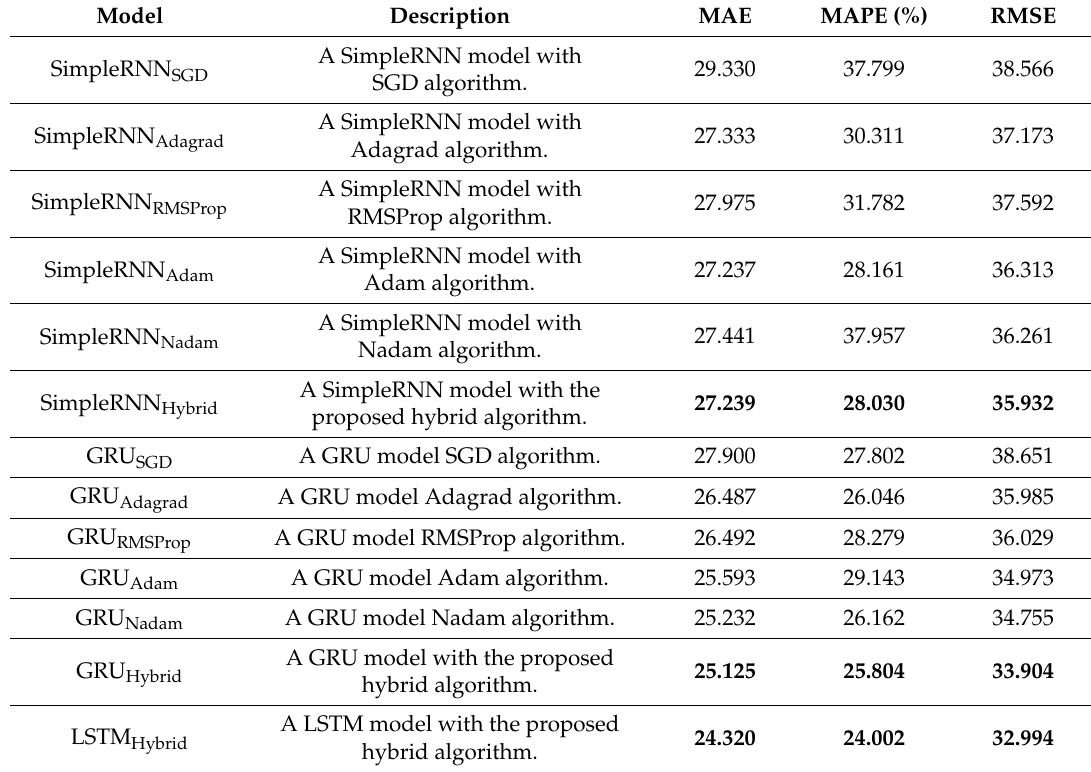
Table 6. Model comparison of RNN and GRU.